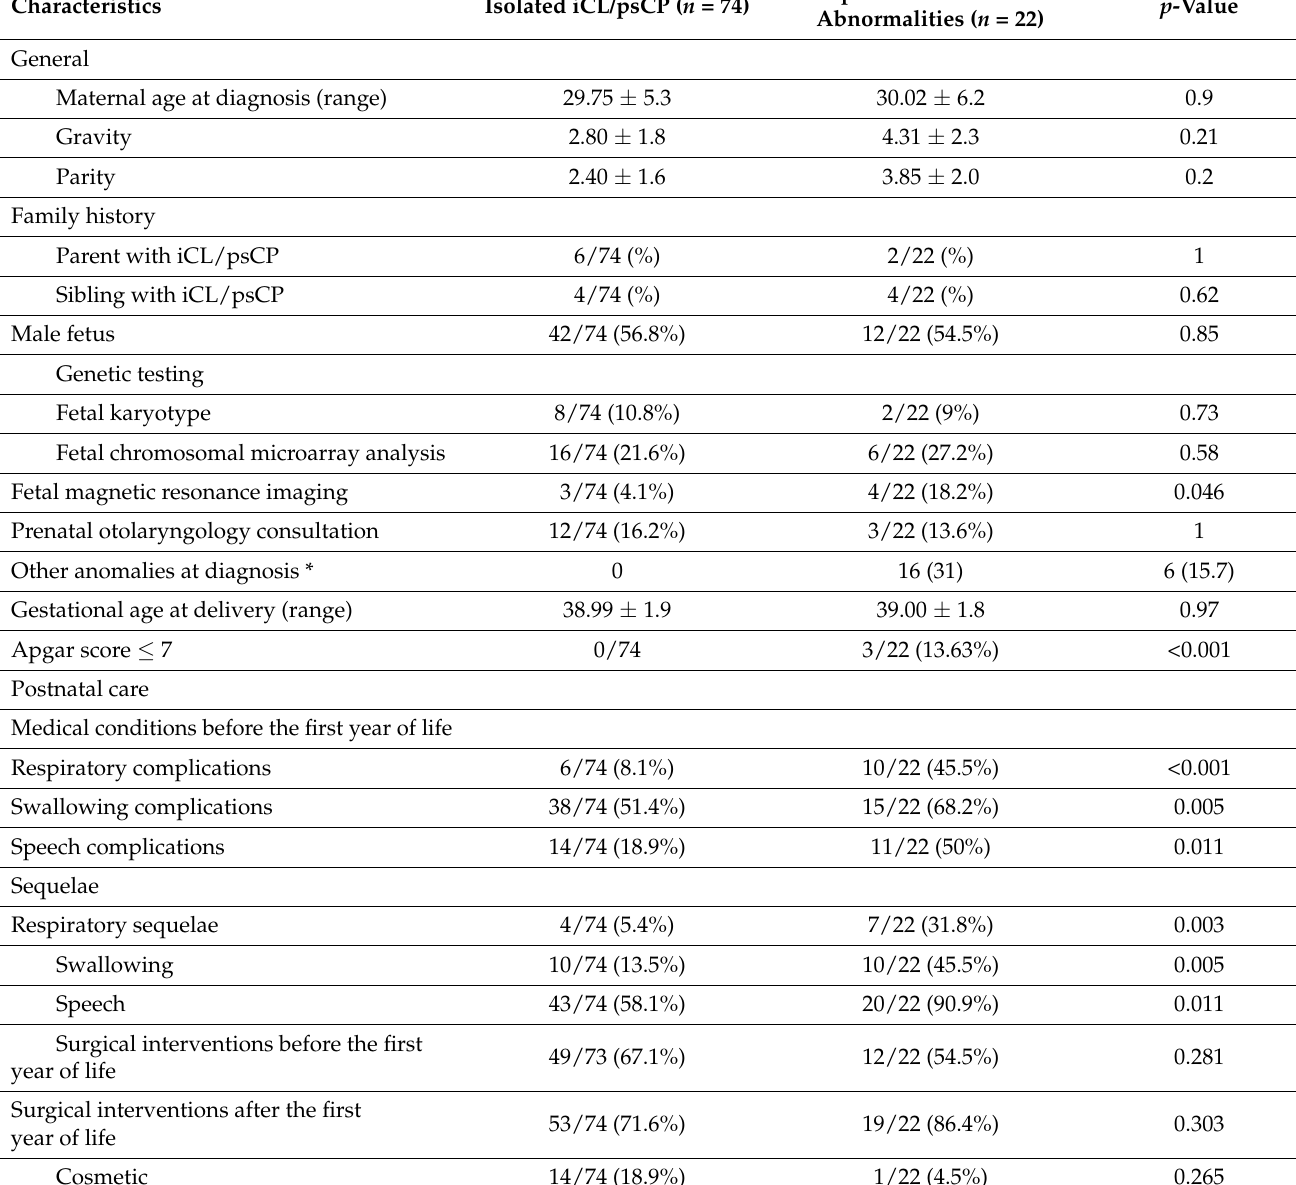
Table 3. Demographic, obstetric, work-up, and outcome of newborns with isolated iCL/psCP versus iCL/psCP associated with additional